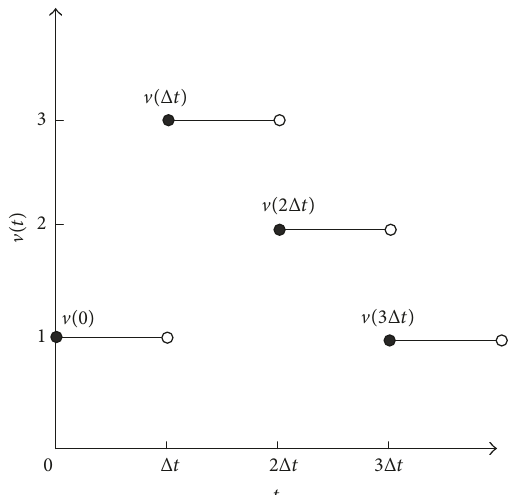
Figure 2: Time-dependent function based on travel speed.